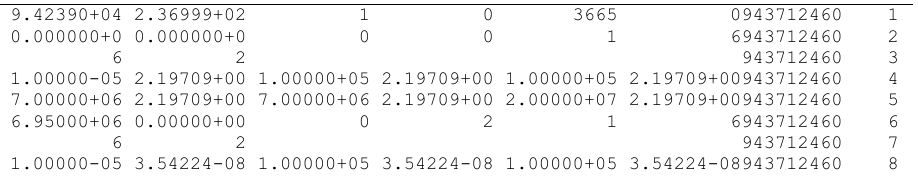
Table 4. Main text lines of beta-delayed fission gamma spectrum of n+ 241 Pu fission in ENDF-6 format (MF=12, MT=460, normalization